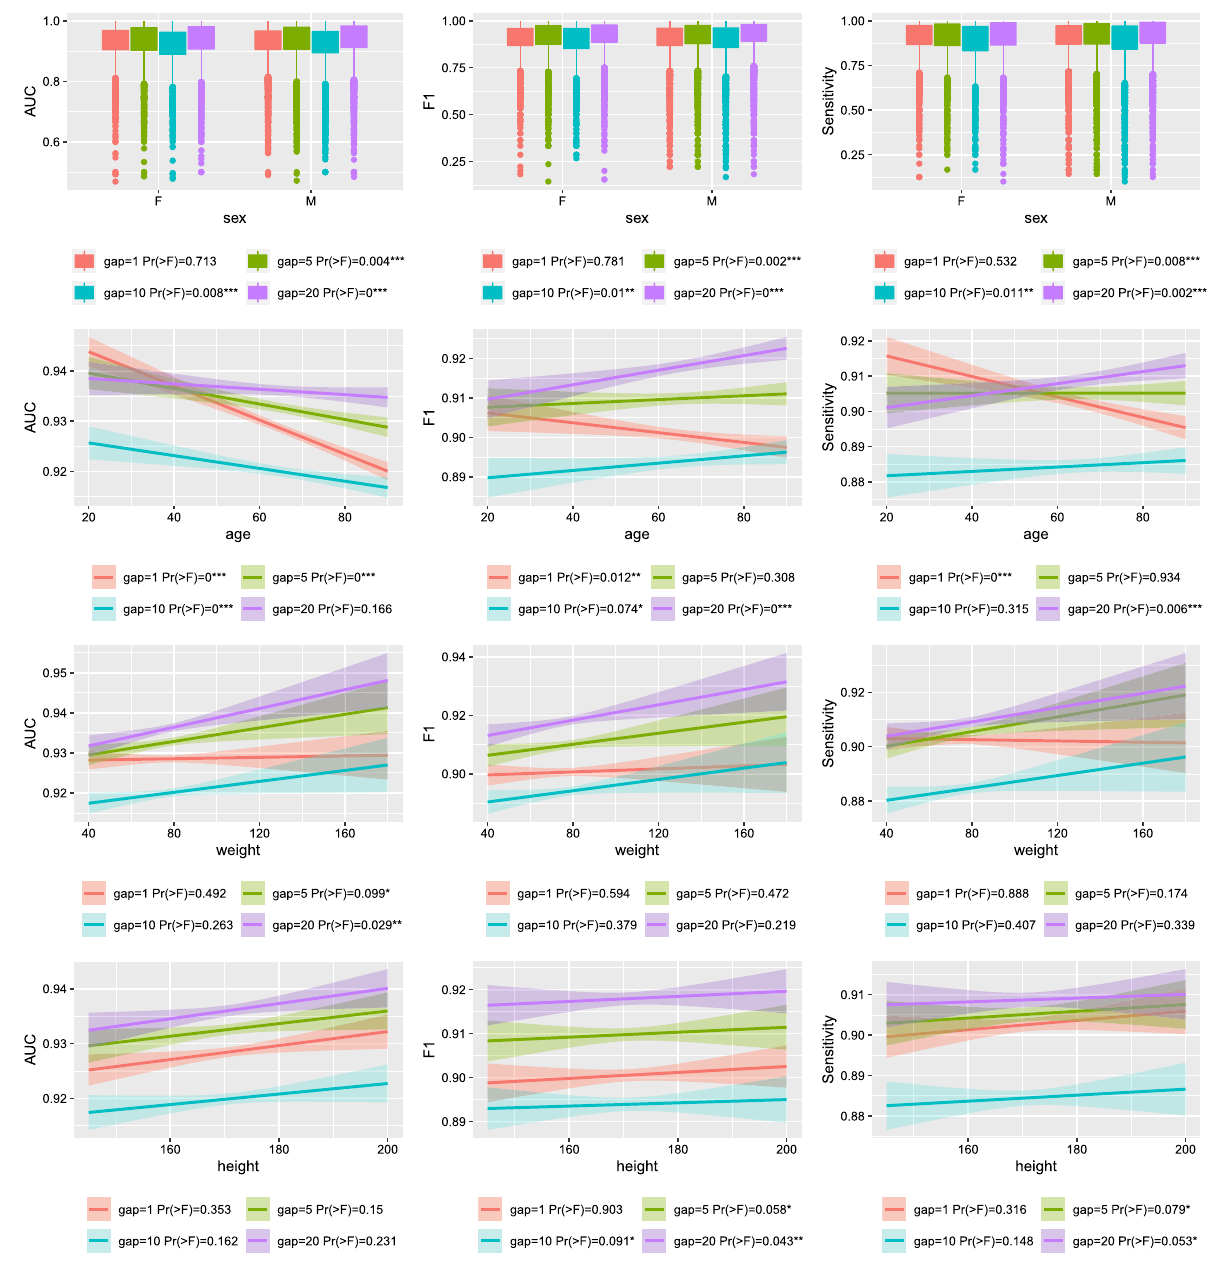
Figure 2. The results of ANOVA test between XGBoost performance and the baseline information under different prediction gaps. The 95% Confidence Interval of linear regression is shown as the shadow area. The probability of the F value is resulted from the ANOVA test. The corresponding significant levels include: 0.001(***), 0.01(**),